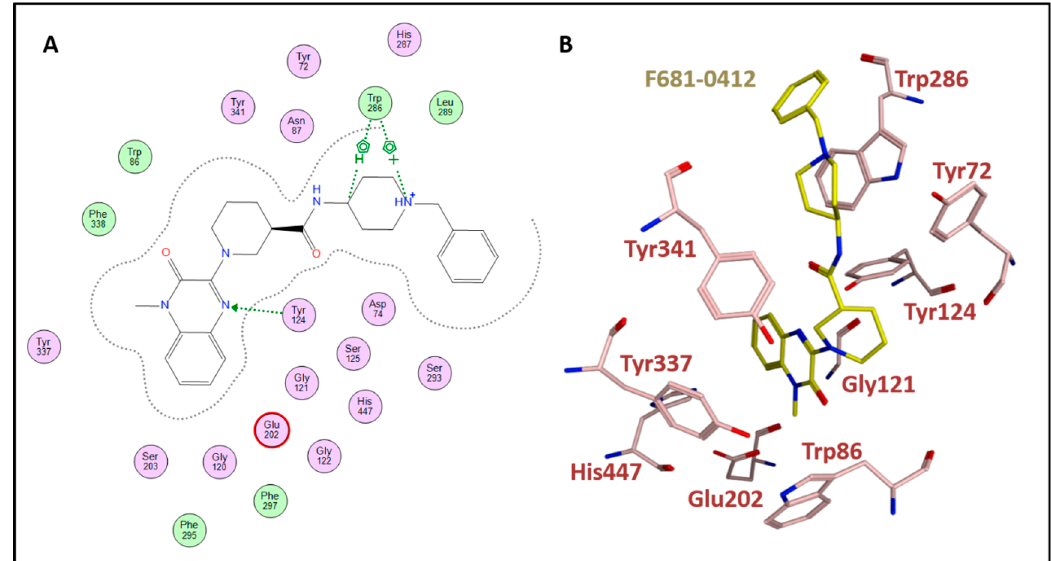
Figure 6. ( A ) The interactions of the dual hit, 3, (F681-0412), with binding site residues in AChE (created with MOE2011). All the important AChE residues are present and in close contacts with the ligand. Non-polar residues are colored green, polar residues are colored light purple, acidic residues are further annotated by a red ring. A hydrogen bond is marked with an arrow, and aromatic hydrocarbon interactions with H atom or a cation are marked as well. In addition to the H-bonds shown by arrows, the other residues interact with the ligand by VdW atom–atom interactions. Most of the residues mentioned in Section 2.2.5 and Supplementary Word File, Section 1.10, are shown in this figure. ( B ) A corresponding 3D pose of hit 3.